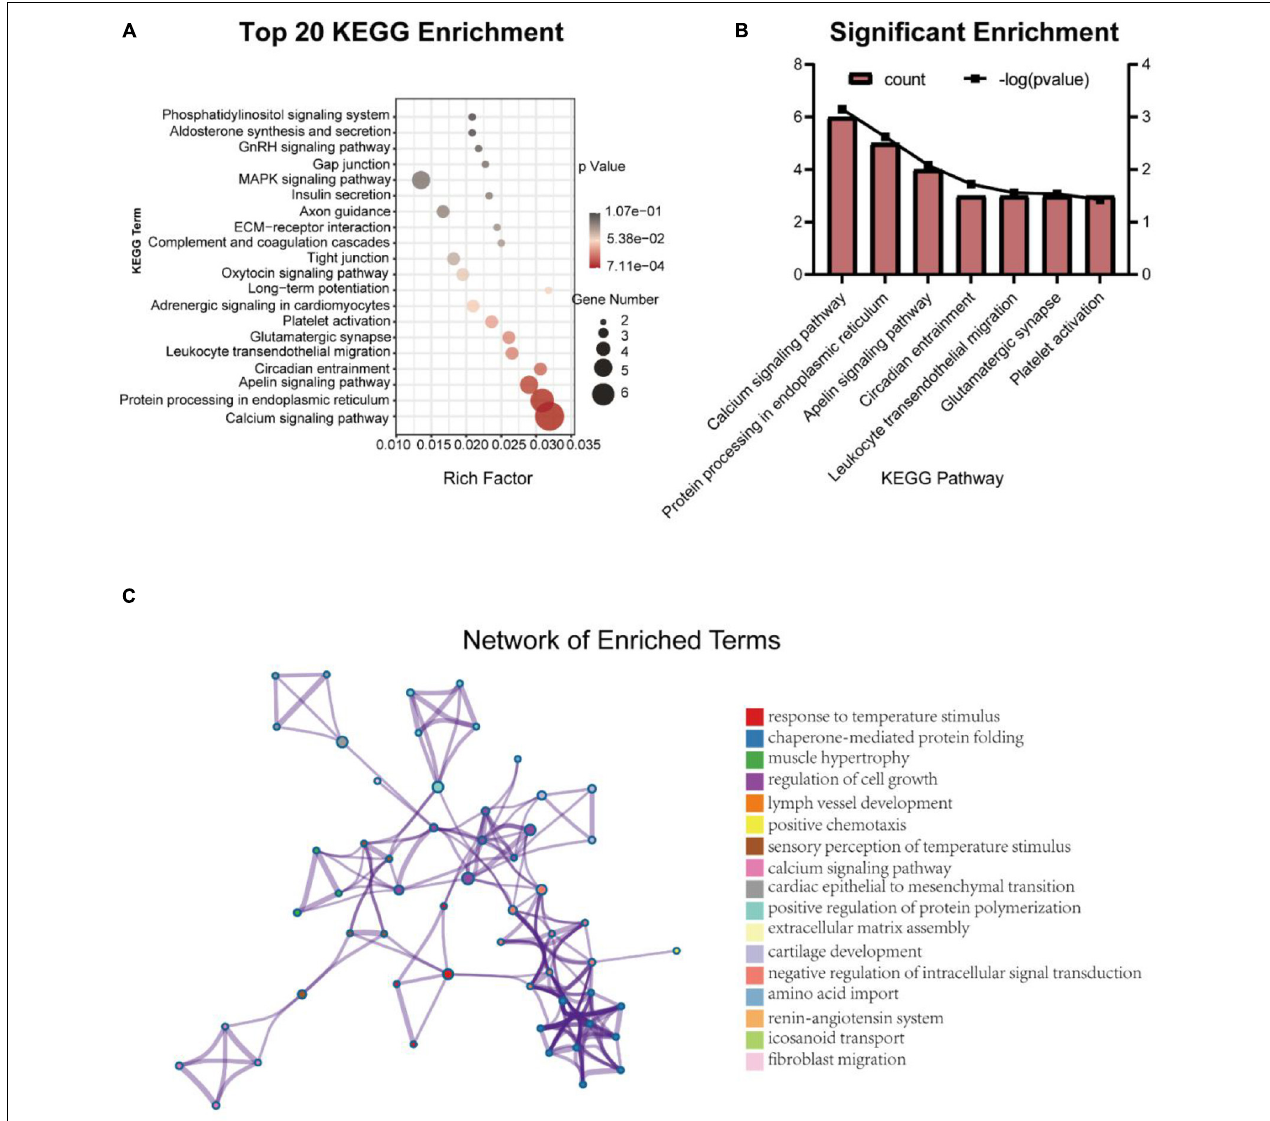
FIGURE 5 | Top 20 Kyoto Encyclopedia of Genes and Genomes enrichment pathways (A) and the significant enrichment pathways (B) , and the network of enrichment terms colored by cluster ID (C) .